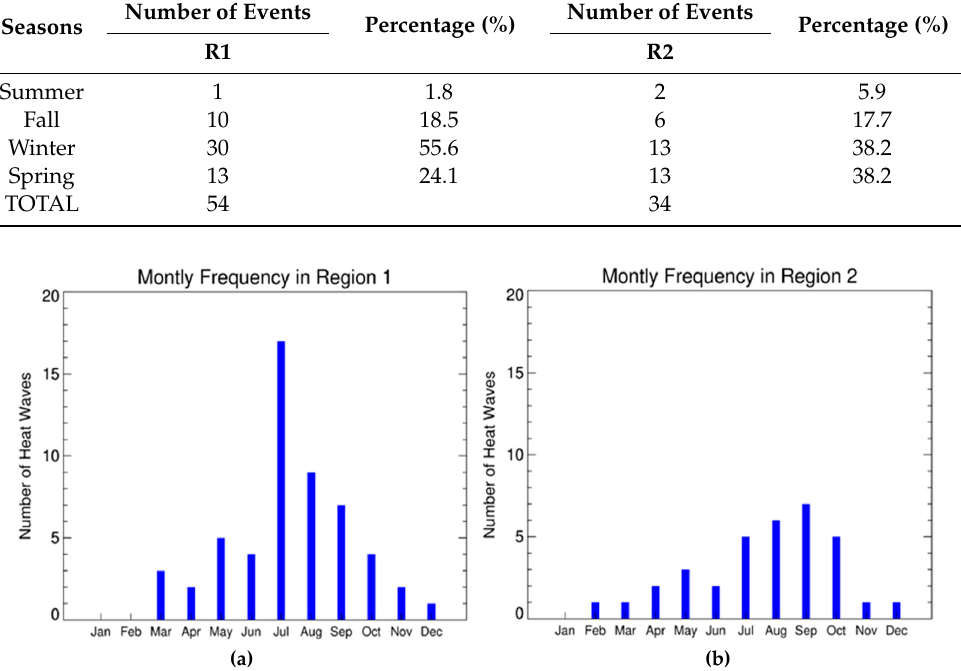
(b) Figure 6. Number of heat wave events per year in regions ( a ) 1 and ( b ) 2 from 1980 to 2013. The red line represents the means of the events. A similar feature of the increasing frequency of extreme temperatures in Brazil since 1980 was found by Bitencourt et al. [28] and Geirinhas [29]. In addition, the result can be compared to other regions of the Southern Hemisphere, such as Australia, and regions of the Northern Hemisphere, such as Europe (including the 2003 mega ‐ heatwave that caused thousands of deaths), Canada,